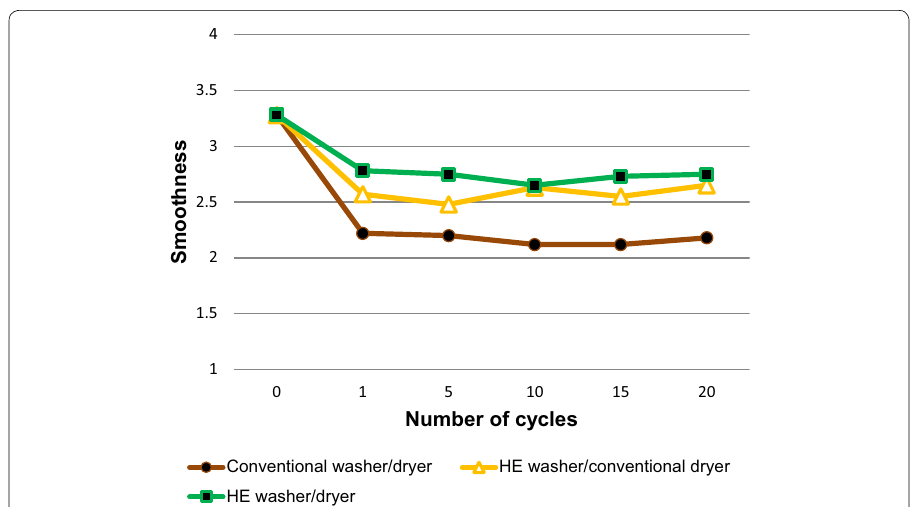
Fig. 3 Fabric smoothness as a function of number of laundering cycles for different combinations of washer and dryer